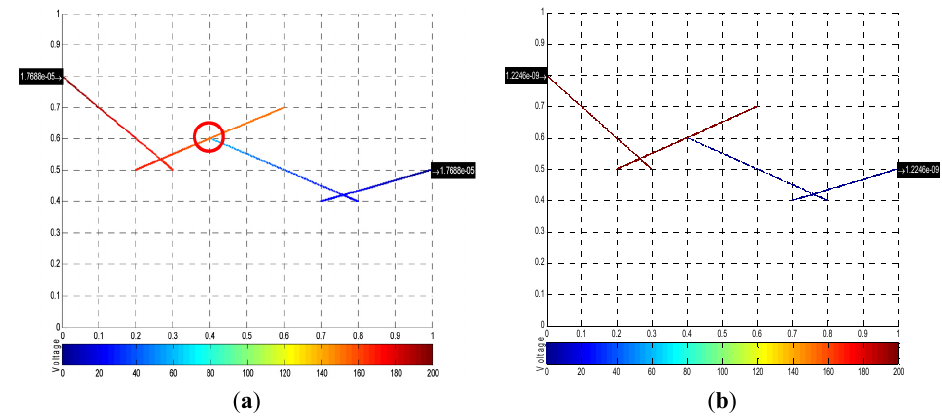
Figure 24. Tunneling resistance as a function of distance between nanotubes.